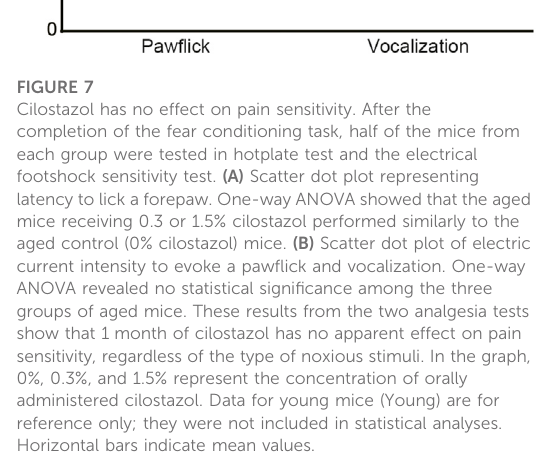
three groups of 1.5% cilostazol group had a greater number of platform crossings (Figure 5C) despite equivalent performance in time spent in the training quadrant (Figure 5D). Somewhat